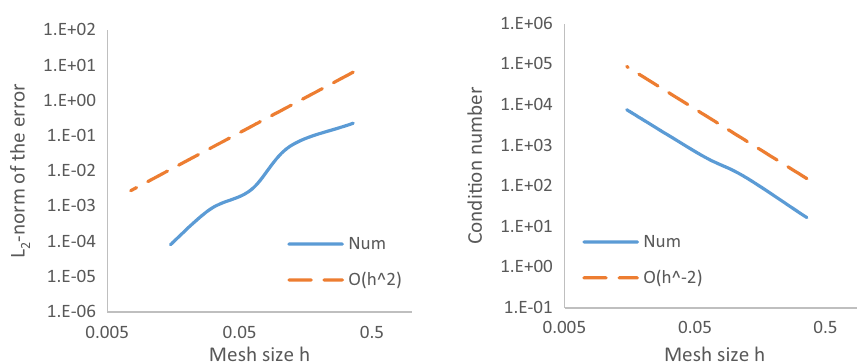
Fig. 8 Plot of the L 2 -norm of the error and 2-norm condition number